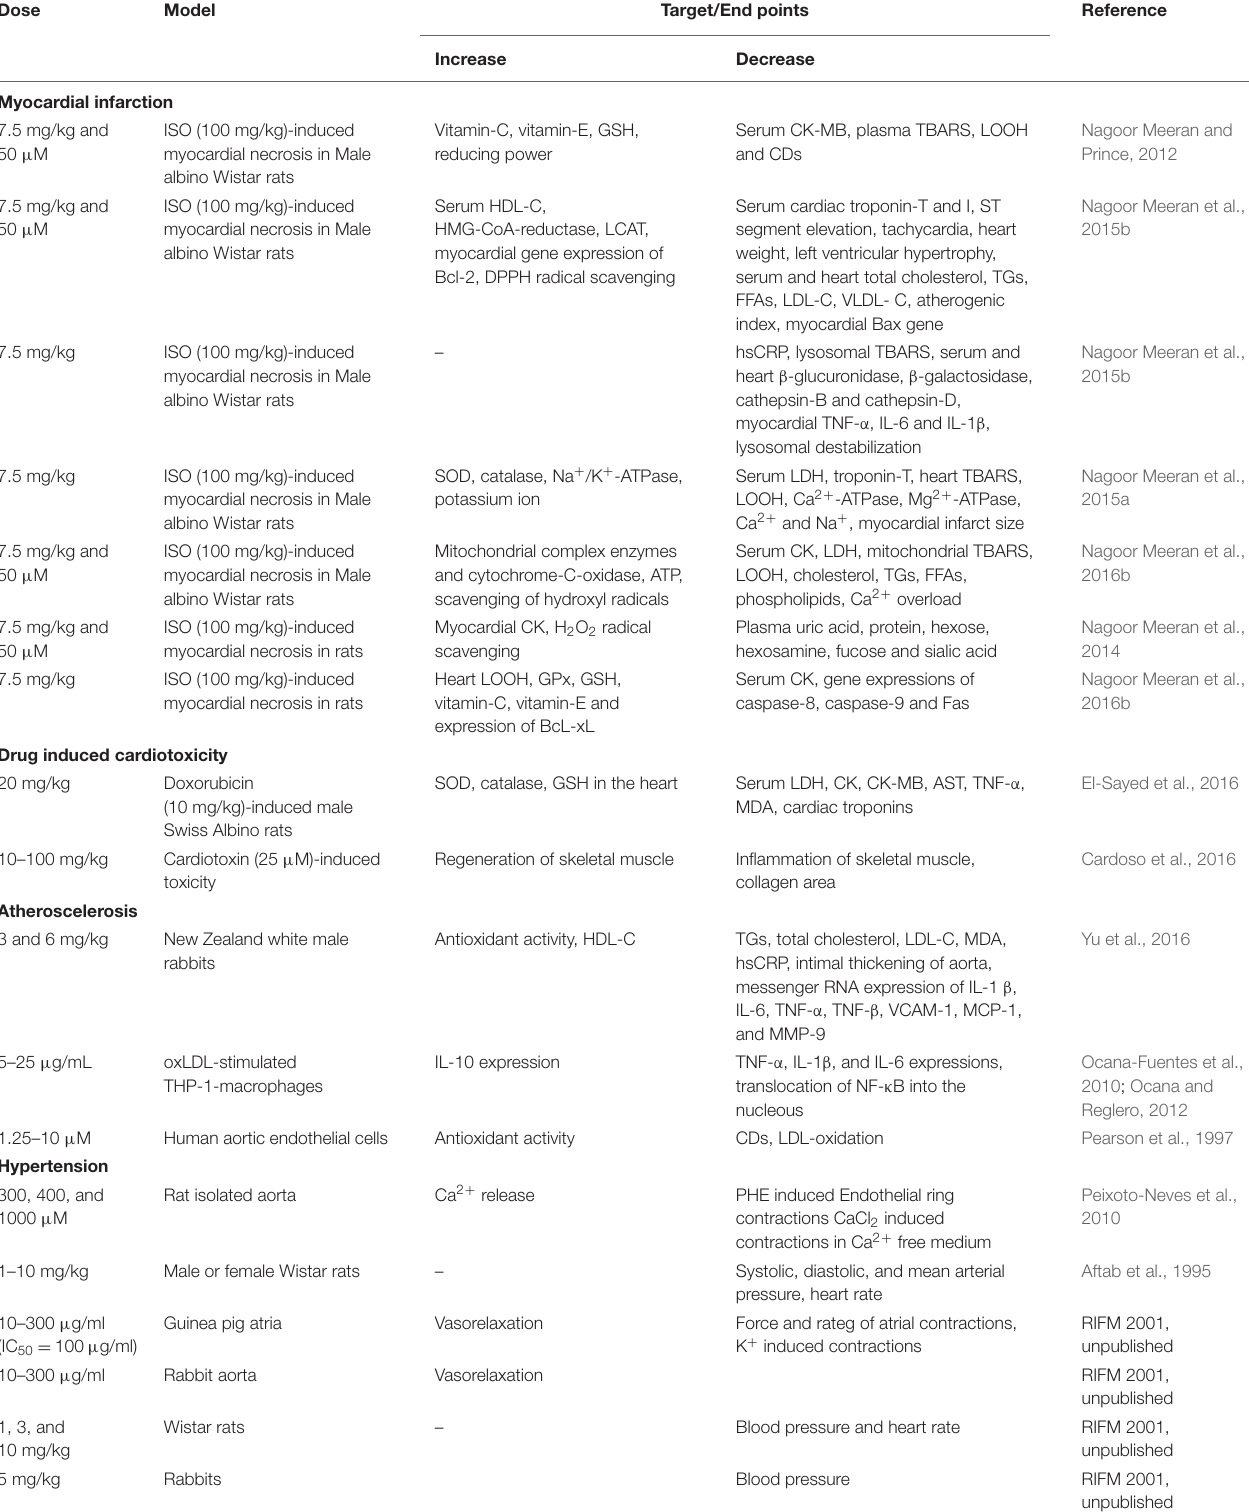
TABLE 2 | Effect of thymol in different animal models of cardiovascular